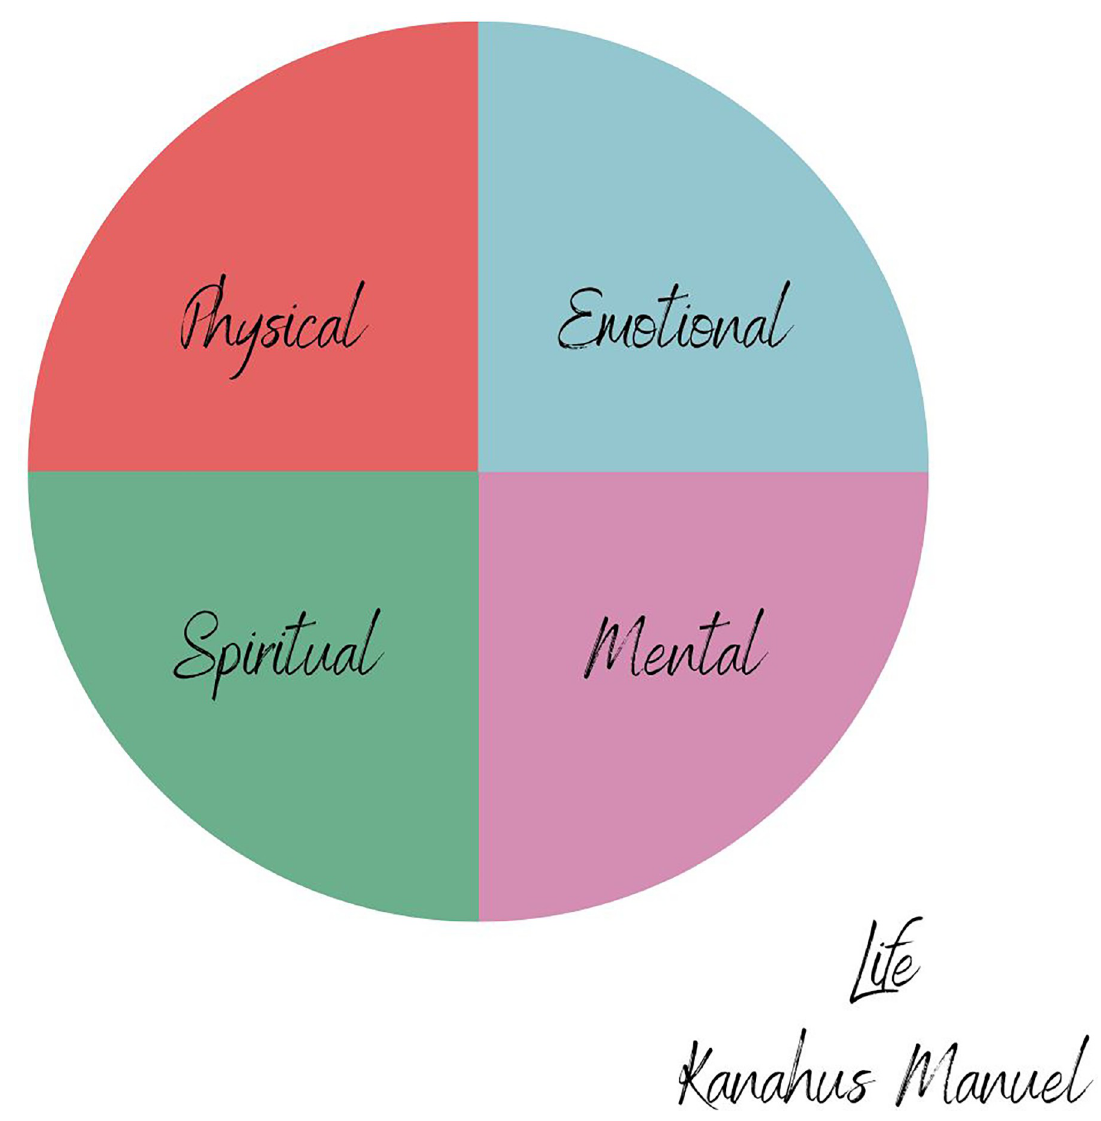
Fig 2. Life by Kanahus Manuel, adapted from the 2021 People’s Health